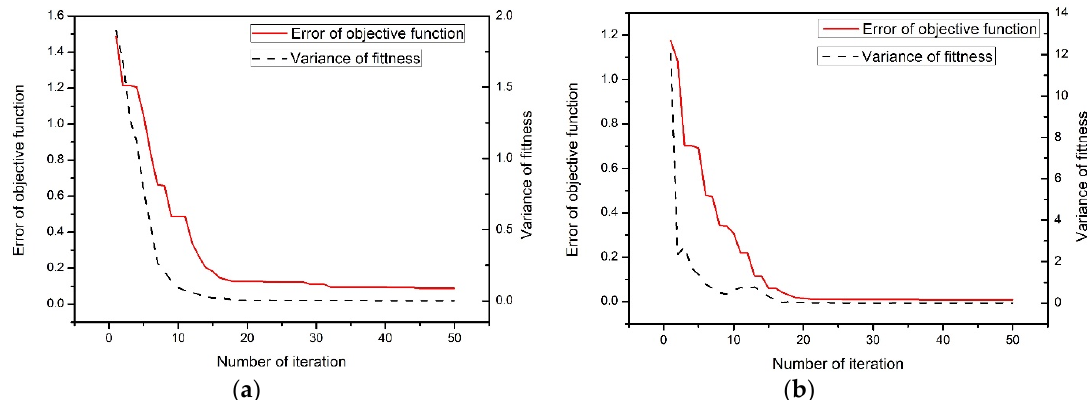
Figure 11. Error versus variance of fitness: ( a ) planar spiral inductor and ( b ) microstrip interdigital capacitor modeled by pure GA with population of 500.